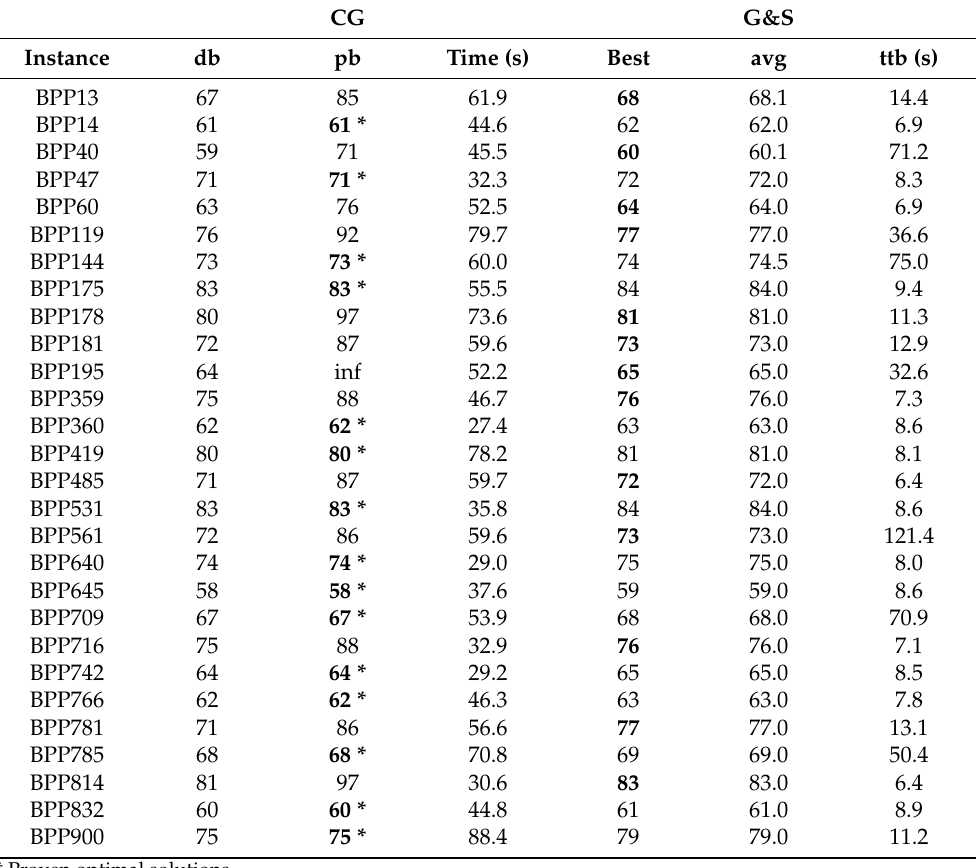
Table 2. Results for the set of instances of class hard28 .